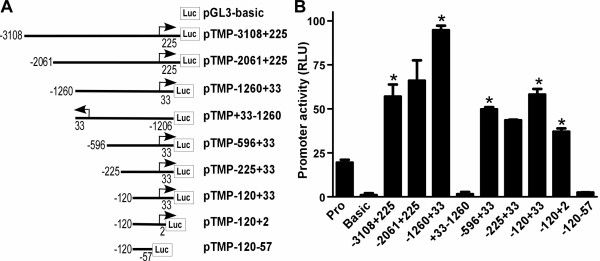
Deletion analysis of the human TMP21 gene promoter. (A) Schematic diagram of the TMP21 promoter constructs consisting of the 5' flanking region with serial deletions cloned into the pGL3-basic vector. Arrow shows the direction of transcription. The numbers represent the end points of each construct. The deletion plasmids were confirmed by sequencing and restriction enzyme digestion. (B) The plasmid constructs were co-transfected with pRLuc into HEK293 and SH-SY5Y cells by Lipofectamine 2000R. After 48 hour transfections the cells were harvested and luciferase activity was measured with a luminometer and expressed in Relative Luciferase Units (RLU). Renilla luciferase activity was used to normalize for transfection efficiency. The values represent means ± SEM. *, P < 0.001 by analysis of variance with the post hoc Newman-Keuls test.